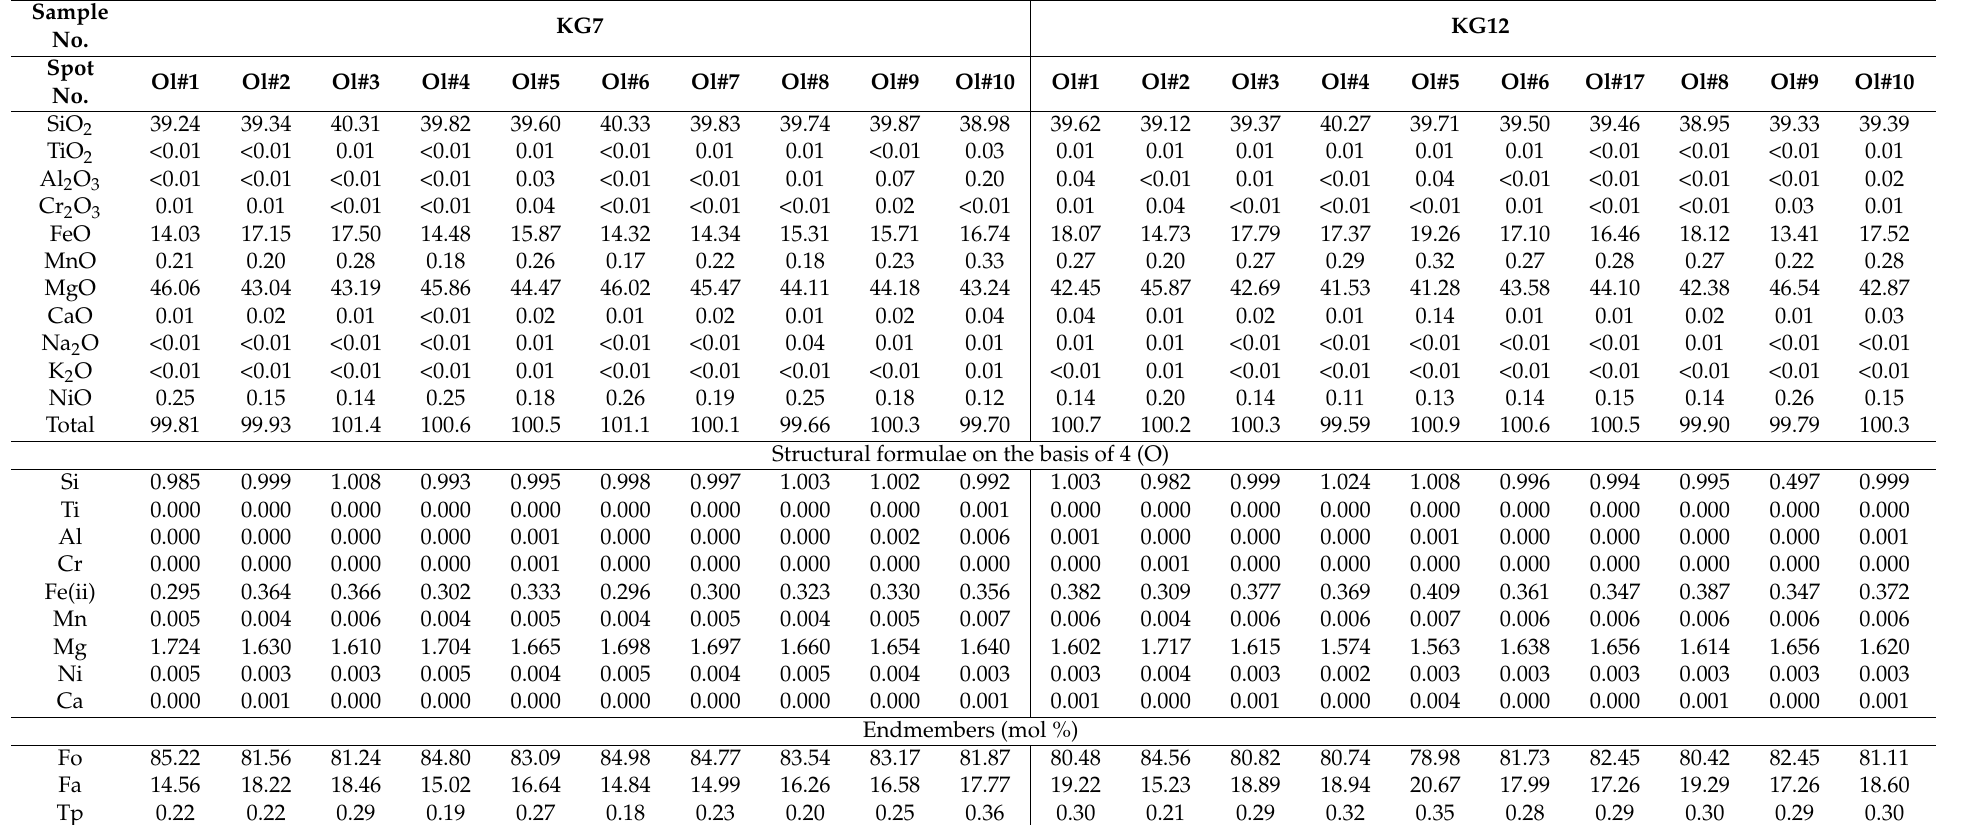
Table 1. Microprobe analyses of olivine in the olivine gabbro of the Khamal mafic